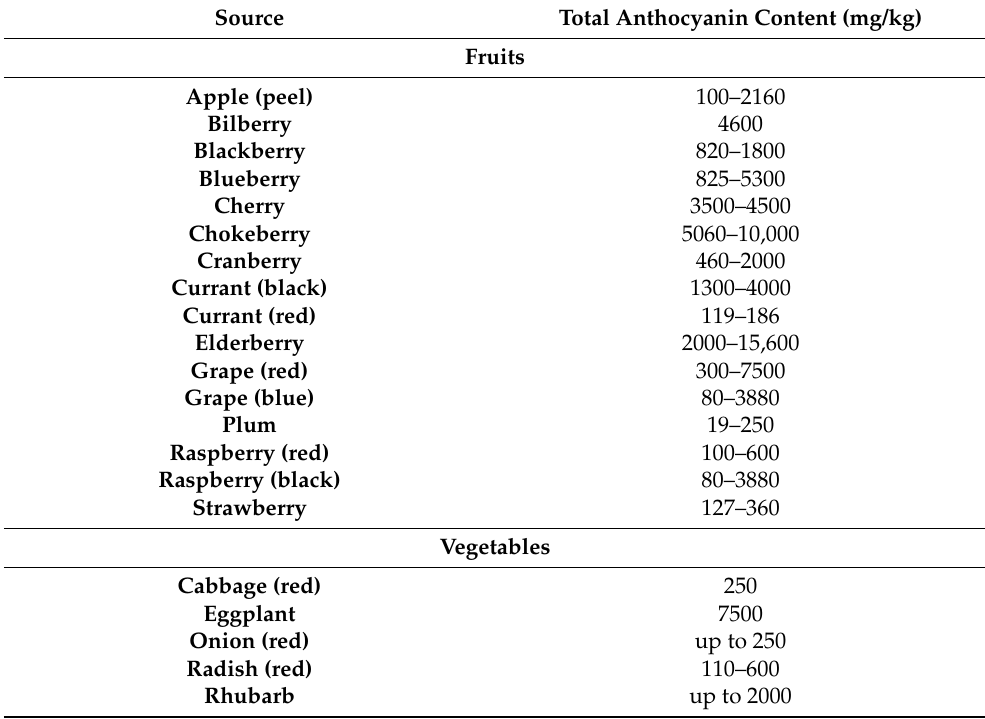
Table 2. Total anthocyanin content of various anthocyanin sources